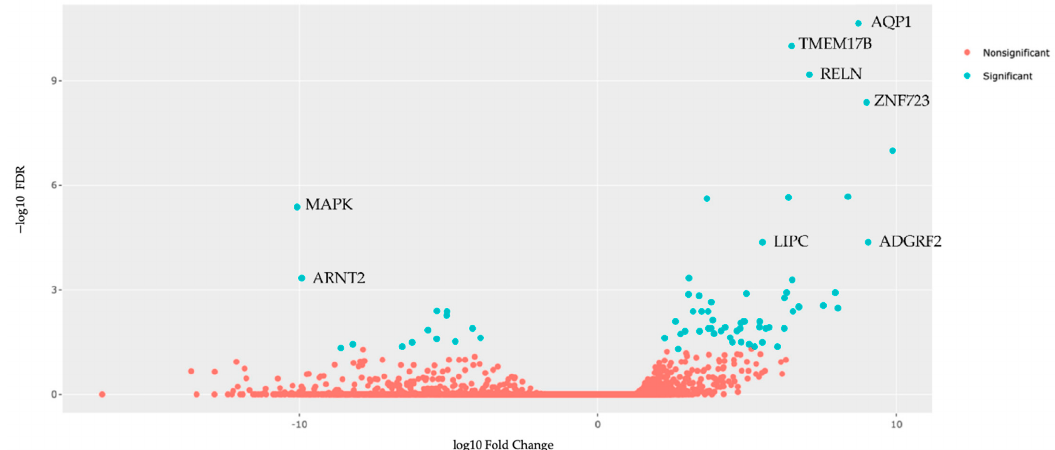
Figure 5. Volcano plot of the 71 differentially expressed genes identified when the carboplatin-resistant TO line (UK1254) is compared to the carboplatin-sensitive TO lines (UK1236, UK1267, UK1393, UK2238, and UK2326). The top upregulated and downregulated differentially expressed genes comparing the carboplatin-resistant group to the carboplatin-sensitive group are displayed in Table 4. In the top ten upregulated genes, many are involved in transmembrane transport, cellular differentiation, and immune response modulation. In the top ten downregulated genes, many are involved in regulation of cellular growth, cellular stress response, and lipid metabolism. Notably, TMEM178B is not yet linked with an established biological pathway identifier and may represent a novel finding. Table 4. Top differentially expressed genes comparing the carboplatin-resistant group to the carboplatin-sensitive group. ( A ) Upregulated pathways in carboplatin-resistant TO compared to the carboplatin-sensitive TO group. ( B ) Downregulated pathways in carboplatin-resistant TO compared to the carboplatin-sensitive TO group. A. Upregulated